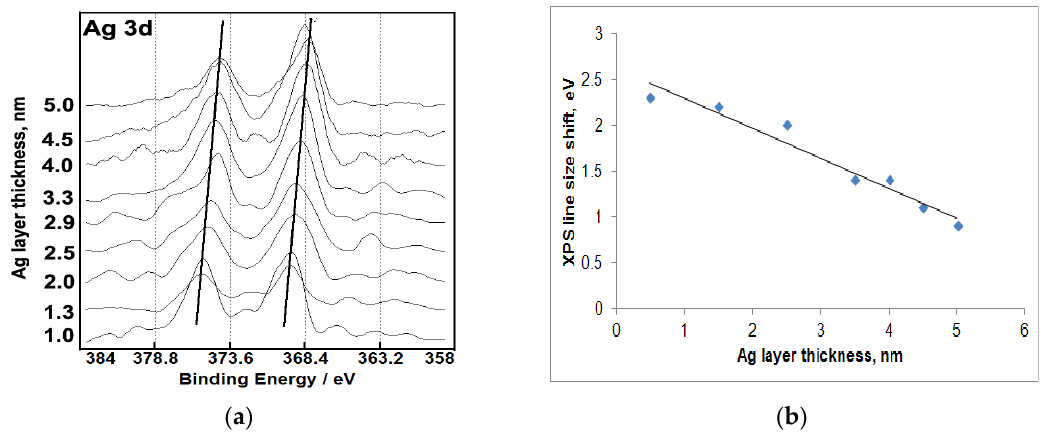
Figure 6. Size shift of Ag 3d binding energies relative to the Ag reference: the set of photoelectron lines from Ag layers with different thicknesses ( a ); size shifts as functions of Ag layer thickness ( b ).